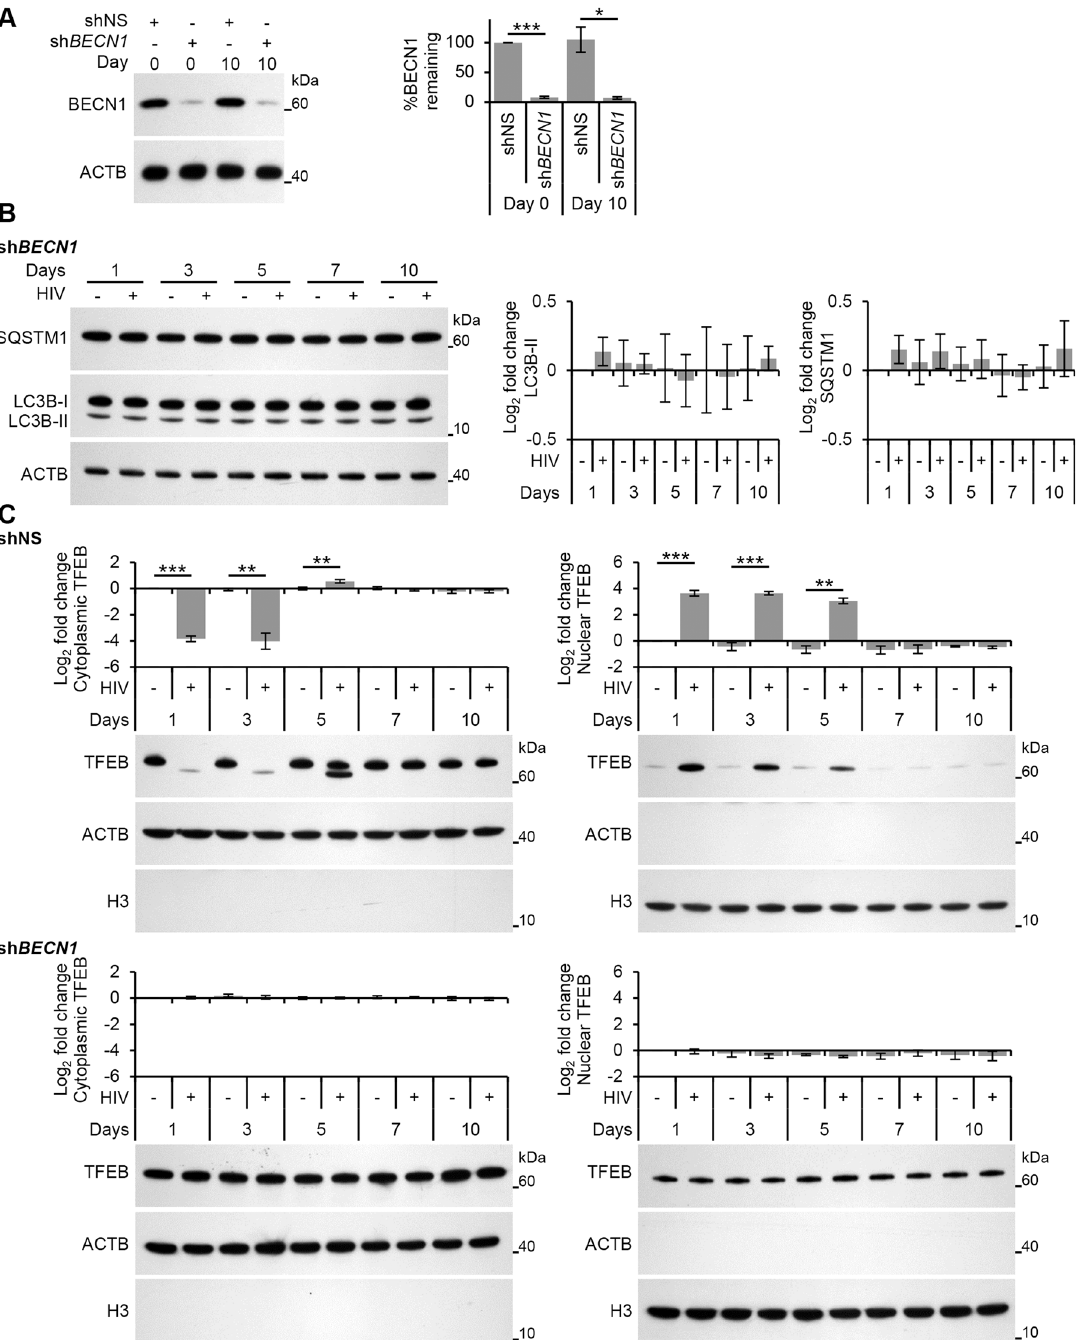
Fig 7. HIV-mediated autophagy induction and nuclear translocation of TFEB is dependent upon BECN1. (A) Macrophages transduced with non- specific scrambled shRNA (shNS), or BECN1 shRNA (sh BECN1 ) were infected with HIV for 10 days. Cells were lysed and analyzed for BECN1 and ACTB content by Western blotting. Left , a representative blot is shown. Right , densitometric analysis of immunoblots from independent donors presented as means ± s.e.m., n = 4. (B) At 1, 3, 5, 7, and 10 days post-infection cells from (A) were harvested, lysed and analyzed for endogenous LC3B, SQSTM1, and ACTB by Western blotting. Left , a representative blot is shown. Right , densitometric analysis of immunoblots from independent donors presented as means ± s.e.m., n = 4. (C) At 1, 3, 5, 7, and 10 days post-infection cells from (A) were harvested, lysed, fractionated for cytoplasmic and nuclear content, and analyzed for TFEB, ACTB and H3 histone by Western blotting. Left , a representative blot is shown. Right , densitometric analysis of immunoblots from independent donors presented as means ± s.e.m., n =